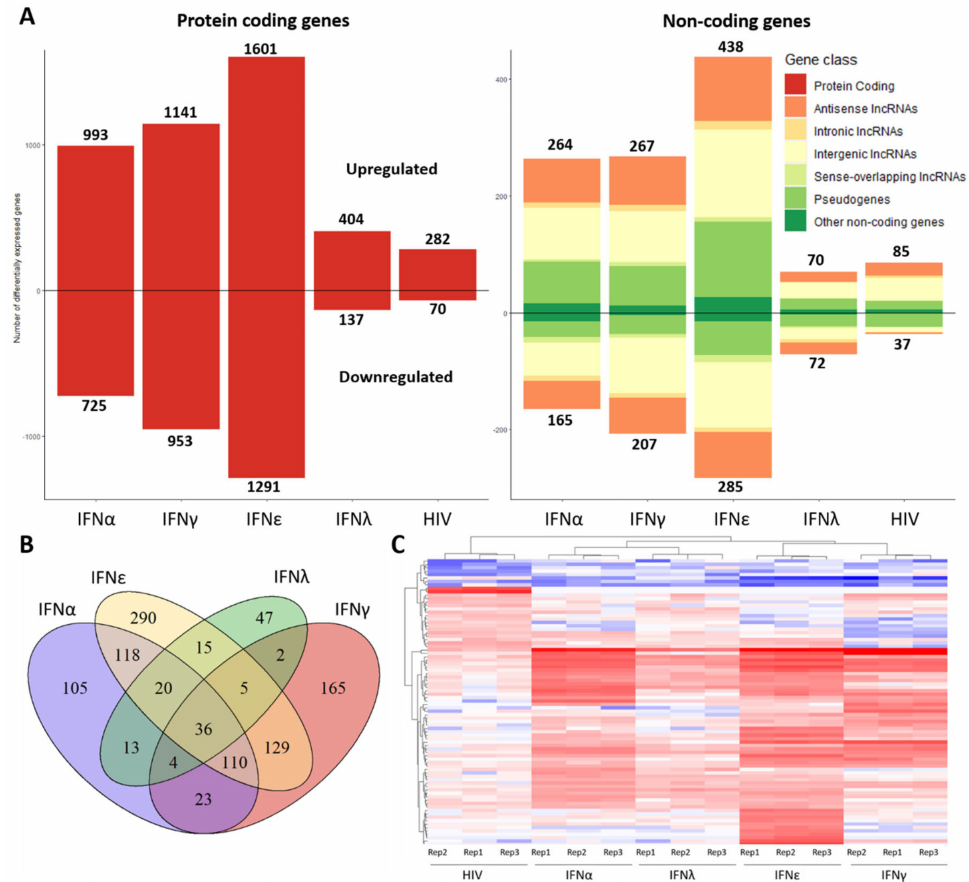
Figure 1. The di ff erential expression profile of macrophages stimulated with IFN- α , IFN- ε , IFN- γ or IFN- λ or infected with HIV-1. ( A ) (Left) The number of di ff erentially expressed protein coding genes (Padj < 0.05; log 2 fold change > 1 or < − 1). (Right) The di ff erentially expressed non-coding genes. ( B ) Venn diagram showing the number of overlapping di ff erentially expressed non-coding genes in the interferon stimulated conditions. ( C ) Heatmap including the top 25 di ff erentially expressed non-coding genes for every condition were included. Color scale indicates the extend of the log 2 fold change for each sample compared to the mean expression of the non-treated control (triplicate). Blue indicates downregulation (log 2 FC < 0), red indicates upregulation (log 2 FC < 0). To validate the RNAseq data, a qPCR quantification was performed on three protein coding genes and five non-coding genes (Figure 2). For protein coding genes MX1, IFIT2 and RSAD2 / viperin, the qPCR analysis is in line with the previously obtained RNAseq results. Only in the HIV-1 infected condition, the qPCR results deviate from the RSAD2 / viperin log 2 fold change observed with RNAseq. The fold change of the non-coding genes NRIR, FIRRE and RP11-177F15.1 observed with qPCR is also in agreement with the RNAseq analysis. DANCR and RP3-477O4.14 have aberrant qPCR results from the RNAseq data in one or two